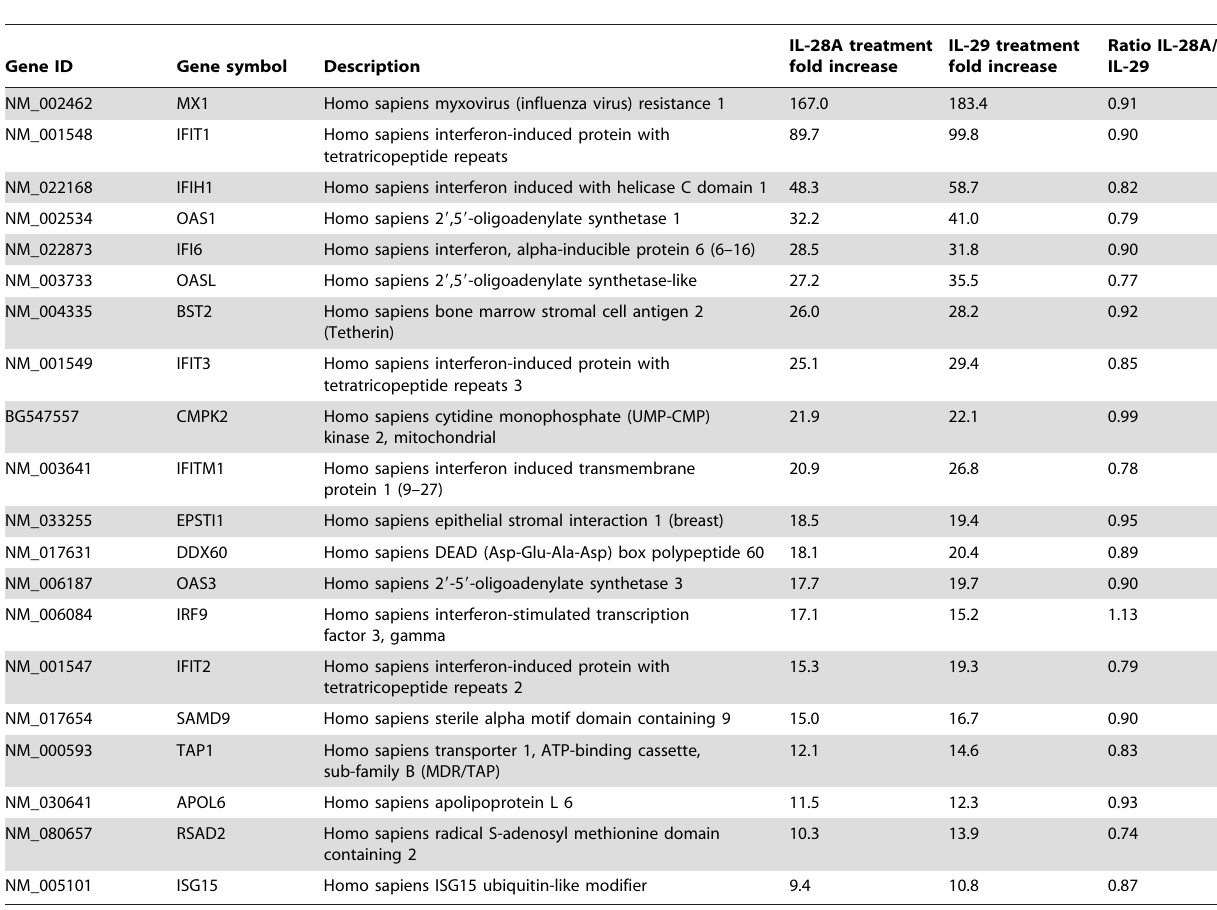
Table 3. Overview of the 20 genes whose expression was most strongly induced (p , 0.01) by IL-28A and IL-29 in Huh-7 cells after 6 hours of